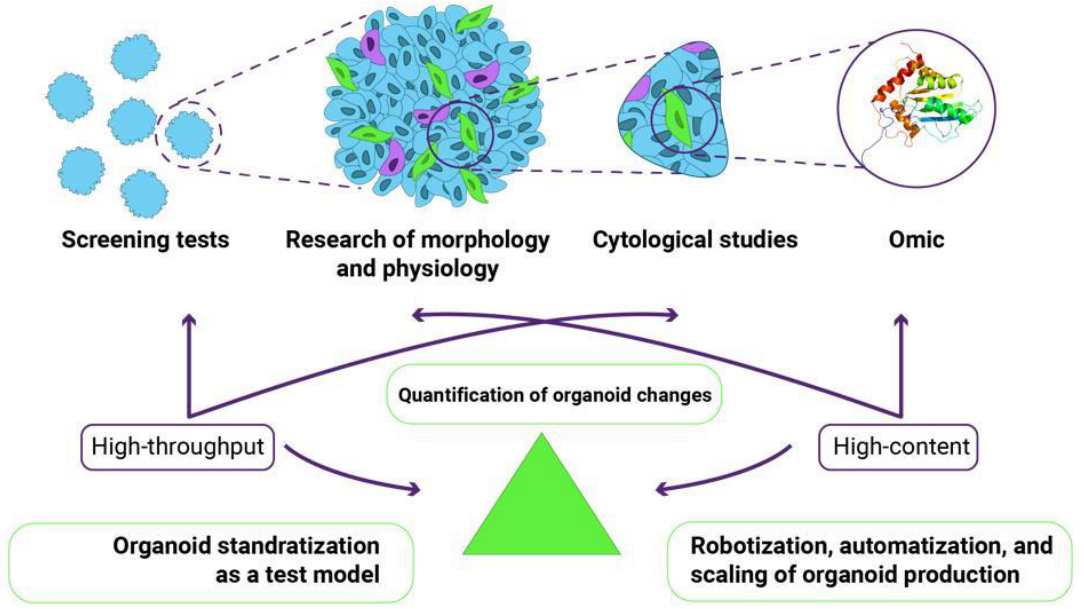
Figure 2. The combination of high-throughput and high-content studies for organoids requires the development and improvement of several methods, namely the automation of organoid production, the standardization of production methods, and the development of standards for assessing mor- phological changes in